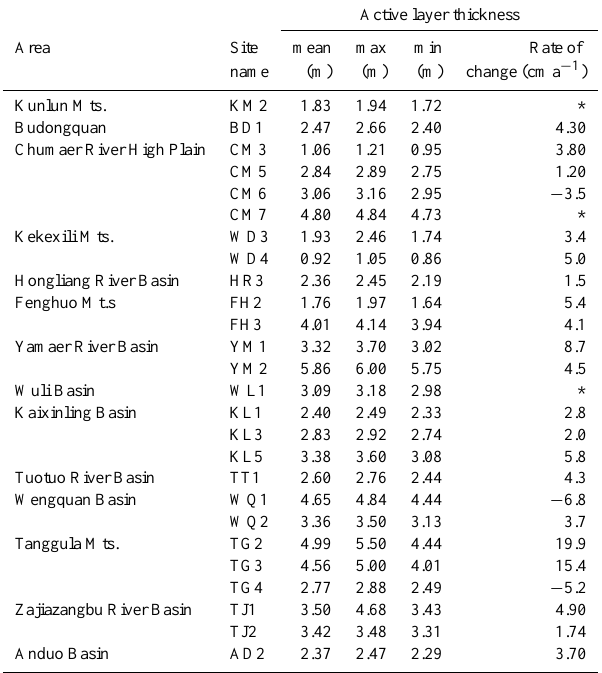
Table 3. Multi-year mean, maximum, minimum, and changing rate of permafrost temperature at 6m depth from